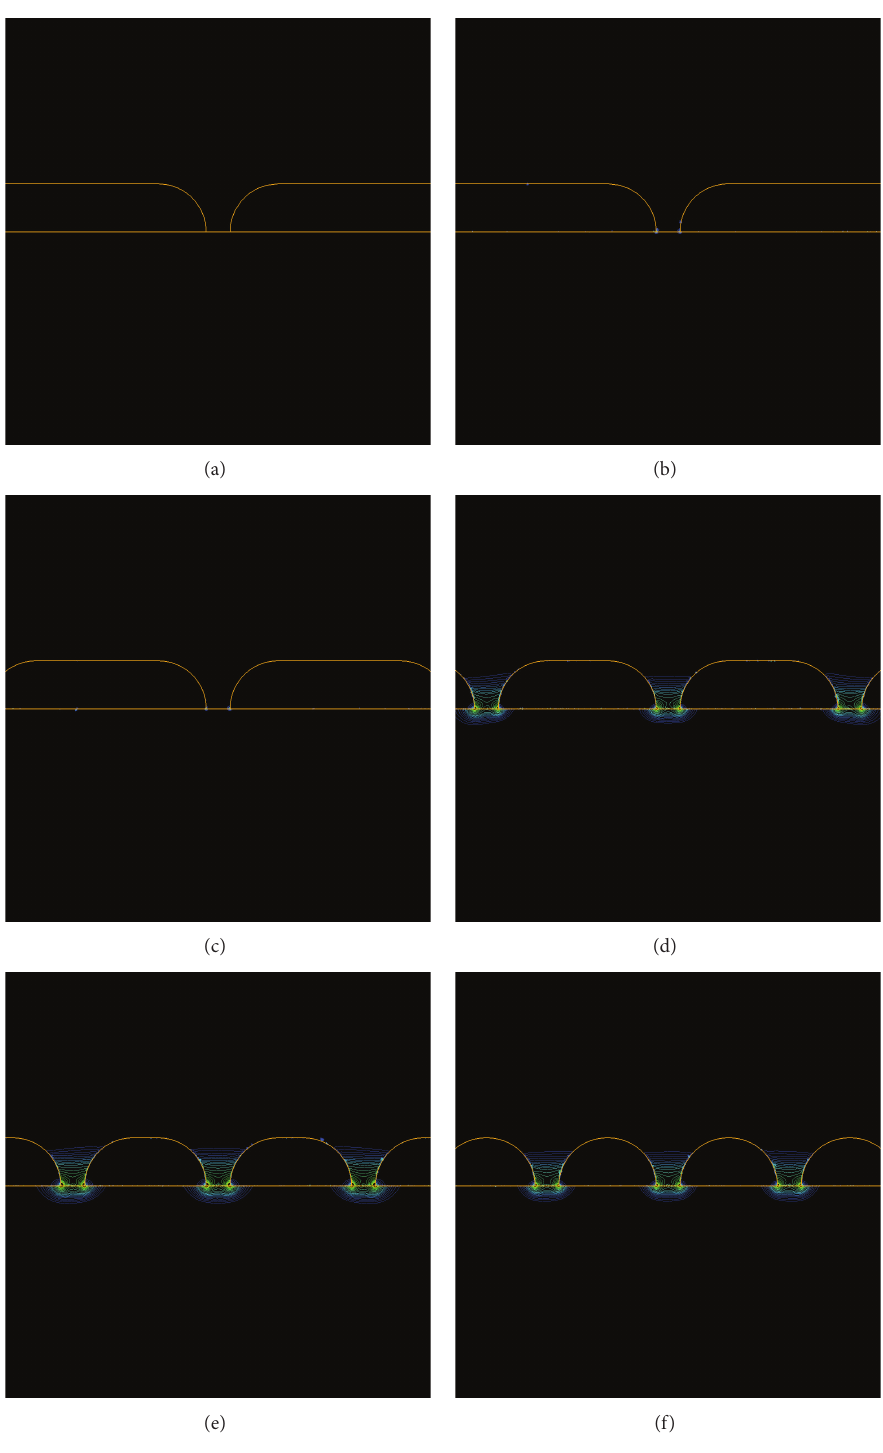
Figure4:Zoominthegapzoneonspatialcontoursoftheelectricfieldfor(a)2,(b)4,(c)6,(d)8,(e)10,and(f)12goldnanostripesilluminated at 𝜆 = 632 nm. The amplitudes and spatial extensions are